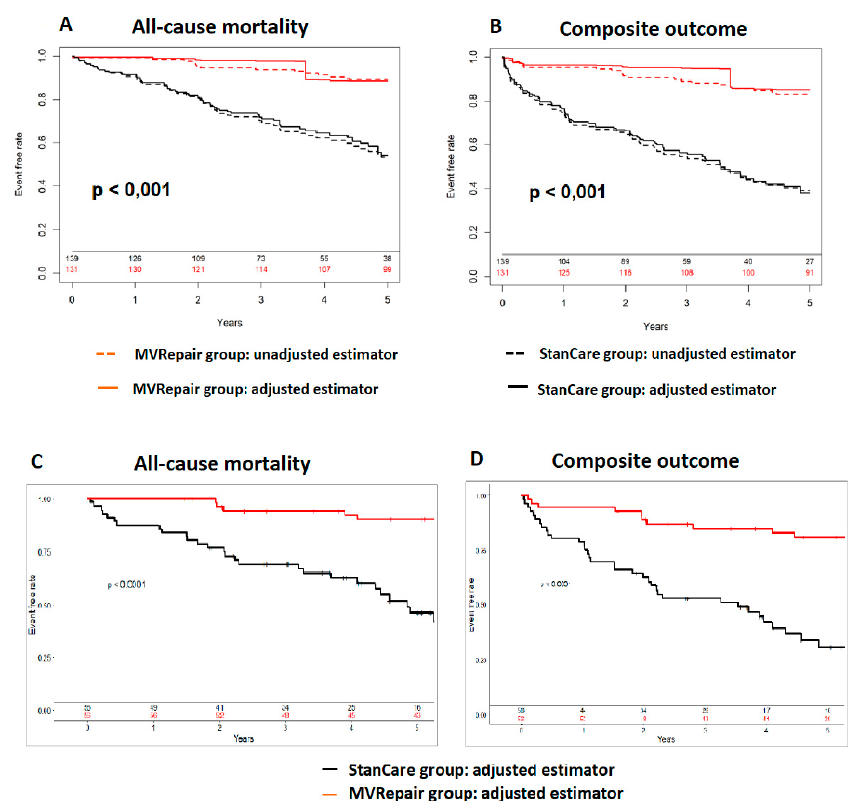
Figure 4. Survival analysis using inverse probability weighting. All-cause mortality ( A ) and its composite with HFpEF readmissions ( B ) after propensity matching for baseline perioperative risk (EuroSCORE II, age, and HYHA class) at 5 years. Unadjusted (dashed lines) and adjusted (solid lines) in the MVRepair (red color) versus the StanCare (black color) groups. Propensity matching resulted in 52 matched pairs. All-cause mortality ( C ) and its composite with HFpEF readmissions ( D ) following propensity matching for relevant clinical characteristics (age, gender, NYHA class, body mass index, hypertension, diabetes mellitus, LV end-diastolic diameter, tricuspid regurgitation grade, and pulmonary artery pressure). The MVRepair group is shown in red, while the StanCare group is shown in black. J. Clin. Med. 2020 , 9 , x FOR PEER REVIEW